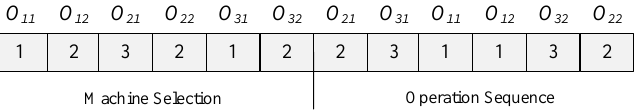
Figure 2. Denotation of Scheduling Scheme (SS).